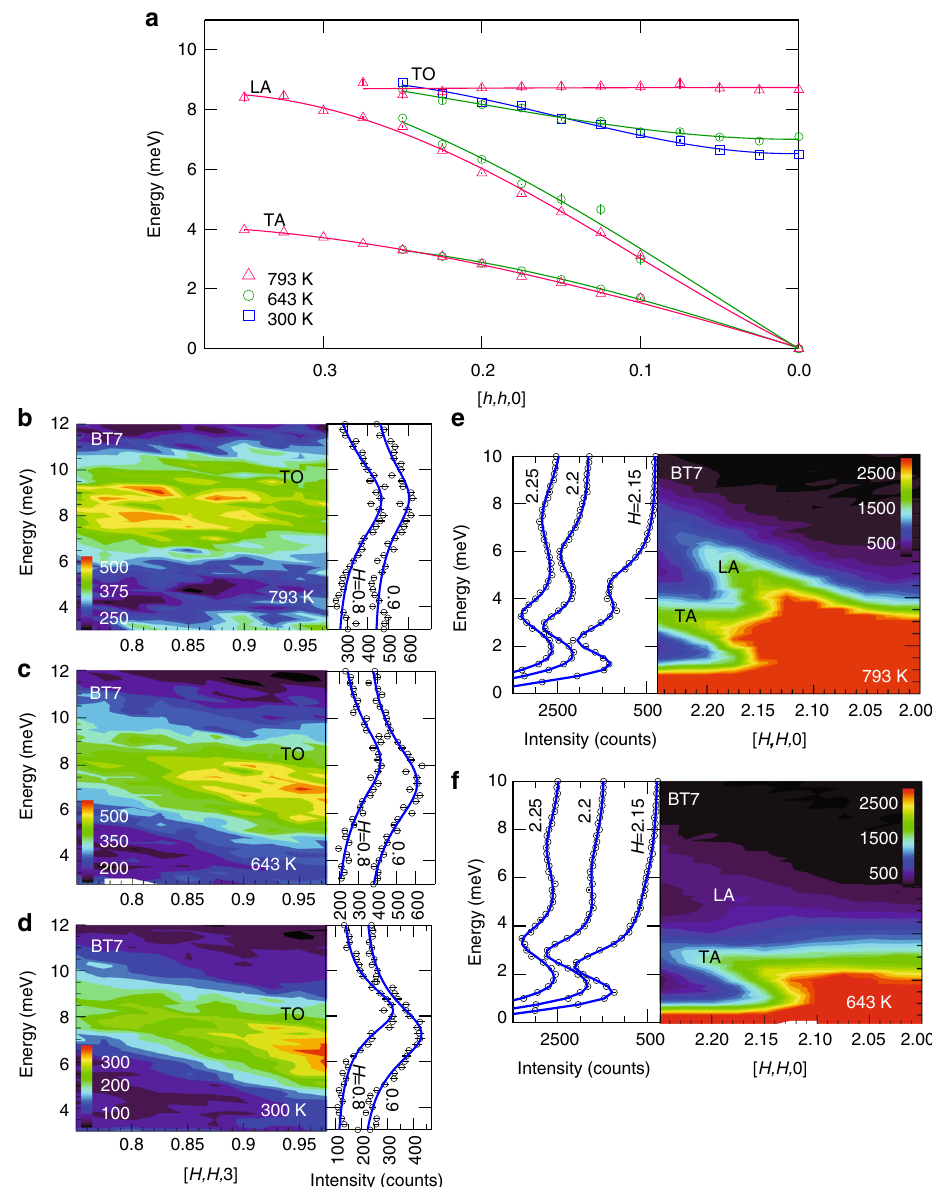
Fig. 1 Triple-axis thermal neutron scattering measurements of the phonons PbSe. a Summary of the temperature dependence of the measured phonon dispersion for the transverse acoustic (TA), longitudinal acoustic (LA), and transverse optic (TO) phonons folded into the fi rst zone along phonon wavevector q = [ h , h , 0]. The data points were determined by fi tting Lorentzians to the data. The fl attening of the TO phonon at 793 K indicates a phonon group velocity, v g = d E /d q , that goes to zero (localization). b – d Temperature dependence of the spectral intensity distribution for the TO phonon measured in the (113) zone along scattering wavevector Q = [ H , H , 3]. Data sets are offset for clarity. e , f Temperature dependence of the spectral intensity distribution for the LA and TA phonons. The TA appears despite the longitudinal geometry because of fi nite Q resolution effects. Surprisingly, the LA phonon is sharper at 793 K than at 643 K. Intensity bars are in counts. Error bars are statistical and represent one